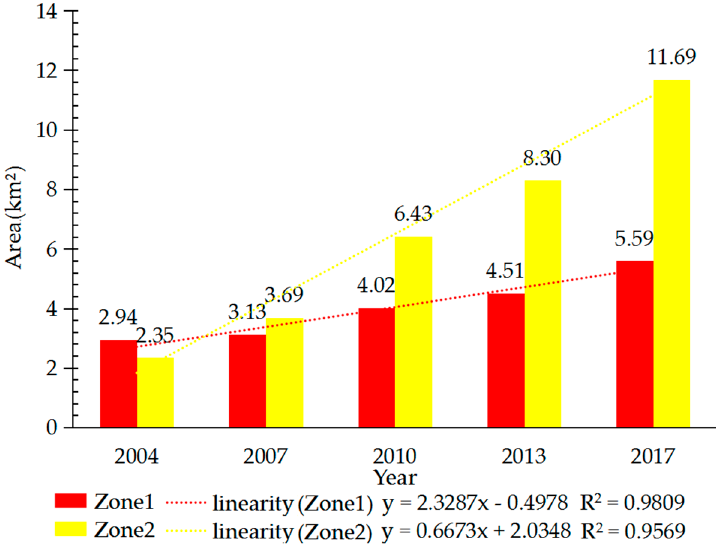
Figure 13. Urban expansions in Zone 1 and Zone 2 from 2004 to 2017.